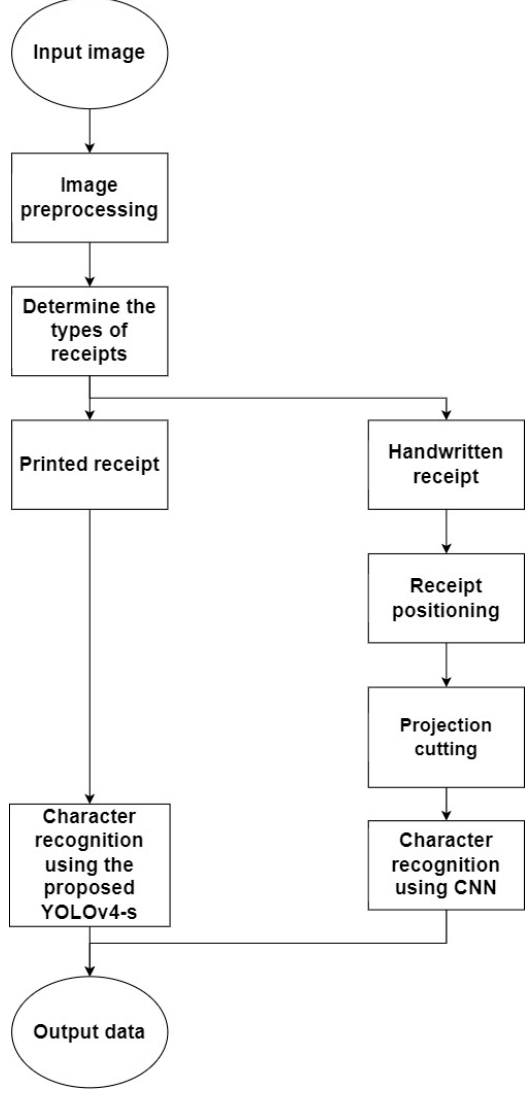
Figure 1. Flowchart of the proposed